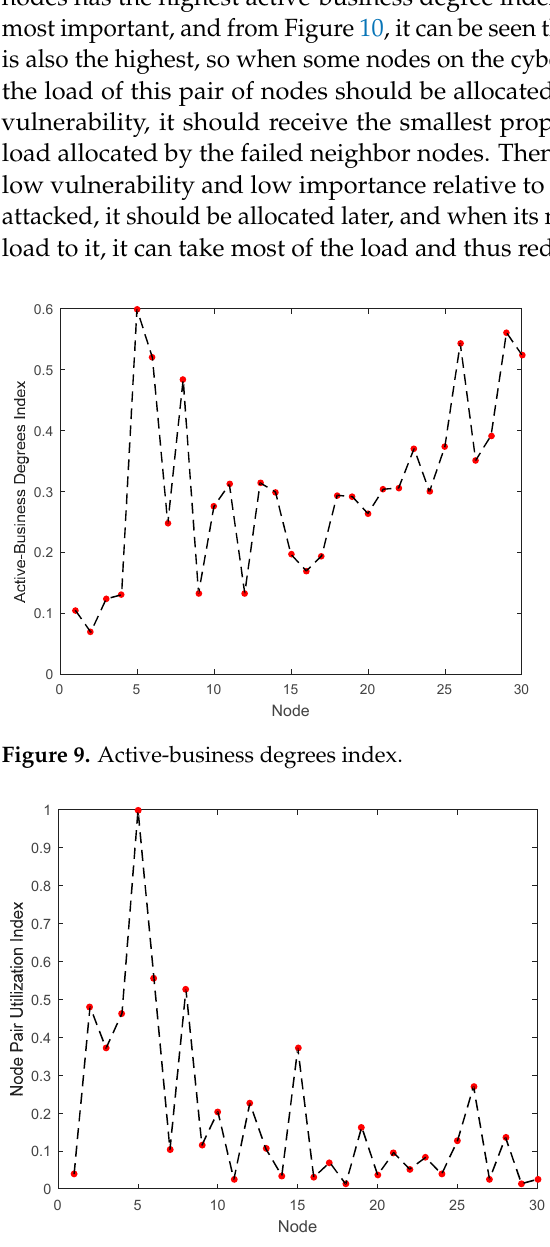
Figure 10. Node pair utilization index.